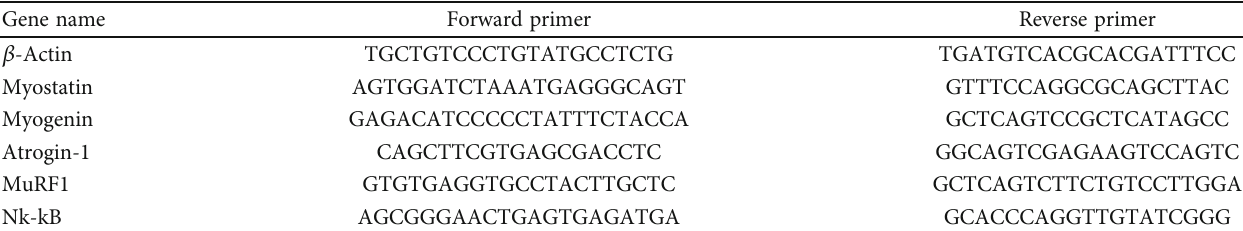
Table 1: Primers ’